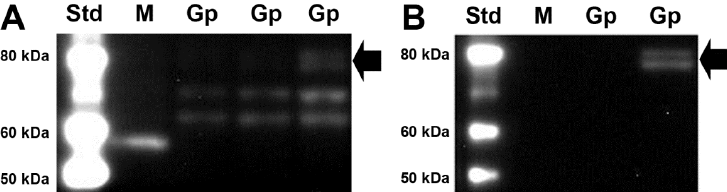
Figure 2. Specificity of anti-SVCT2 in Western blot. ( A ) Specificity of anti-SVCT2 without pre-absorption of antibody with blocking peptide in guinea pig (Gp) brain lysates (HP, BFC, and BC, respectively) seen as a doublet above 60 kDa and in mouse (M) brain lysates as a single band at 60 kDa; ( B ) Show brain lysates of Gp and M with pre-absorption of antibody with blocking peptide. Block arrow show the non-specific band detected in western blots in a few guinea pig brain lysates. Western blot standard ladder (Std) and band lengths are displayed for both blots.